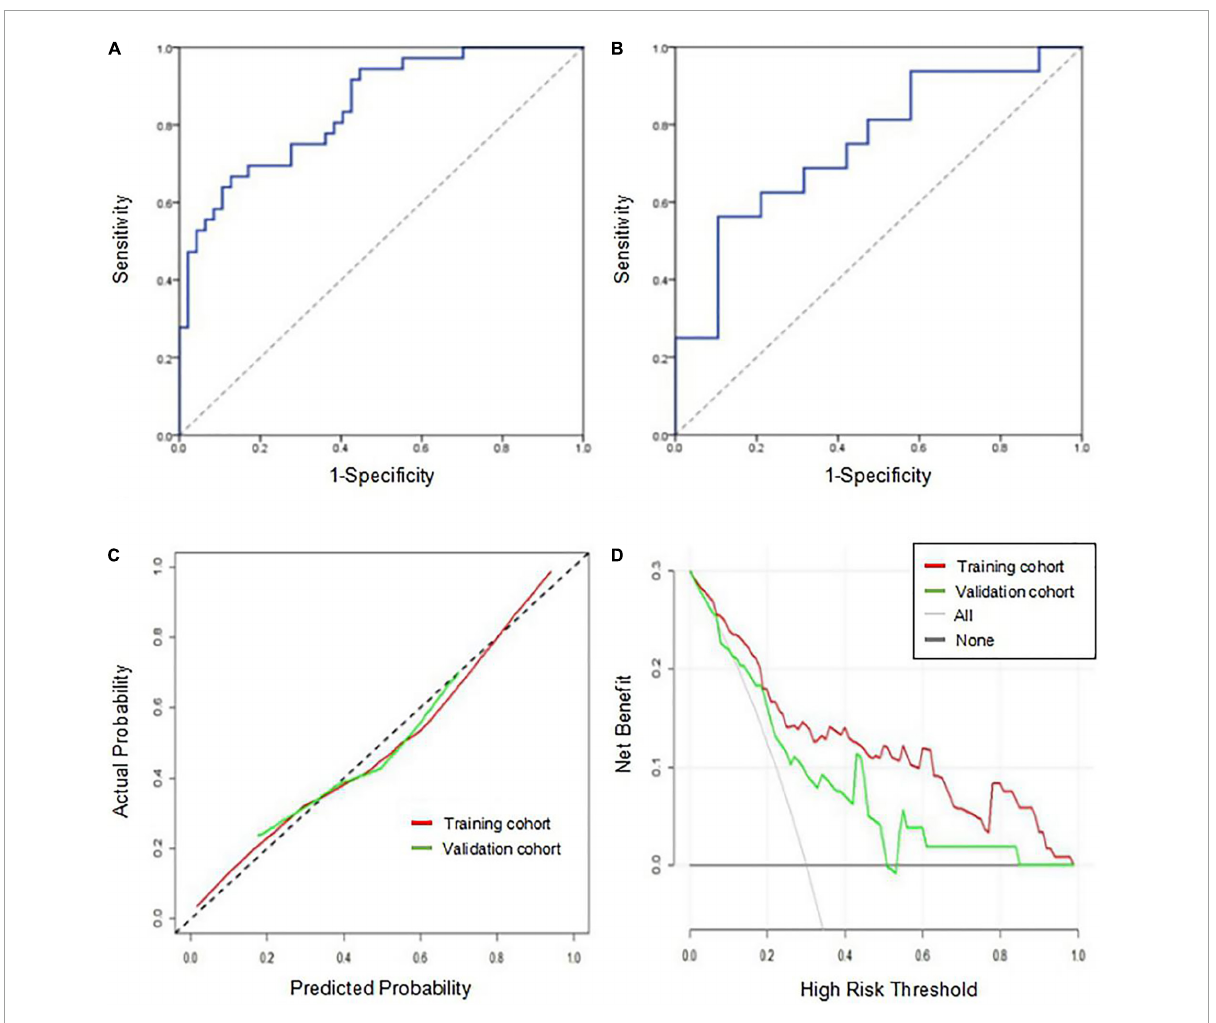
FIGURE4 Performance evaluation of the model in the training and validation cohorts. (A) Receiver operating characteristic curve of the model in the training cohort. (B) Receiver operating characteristic curve of the model in the validation cohort. (C) The calibration curve of the model in the training and validation cohorts. The closer the calibration curve (solid line) is to the diagonal (dotted line), the higher the consistency between the predicted probability and the actual probability. (D) The clinical decision curve analysis of the model in the training and validation cohorts. When the red line and the green line are farther away from the white line on the right and the black line below, the net benefit is high.